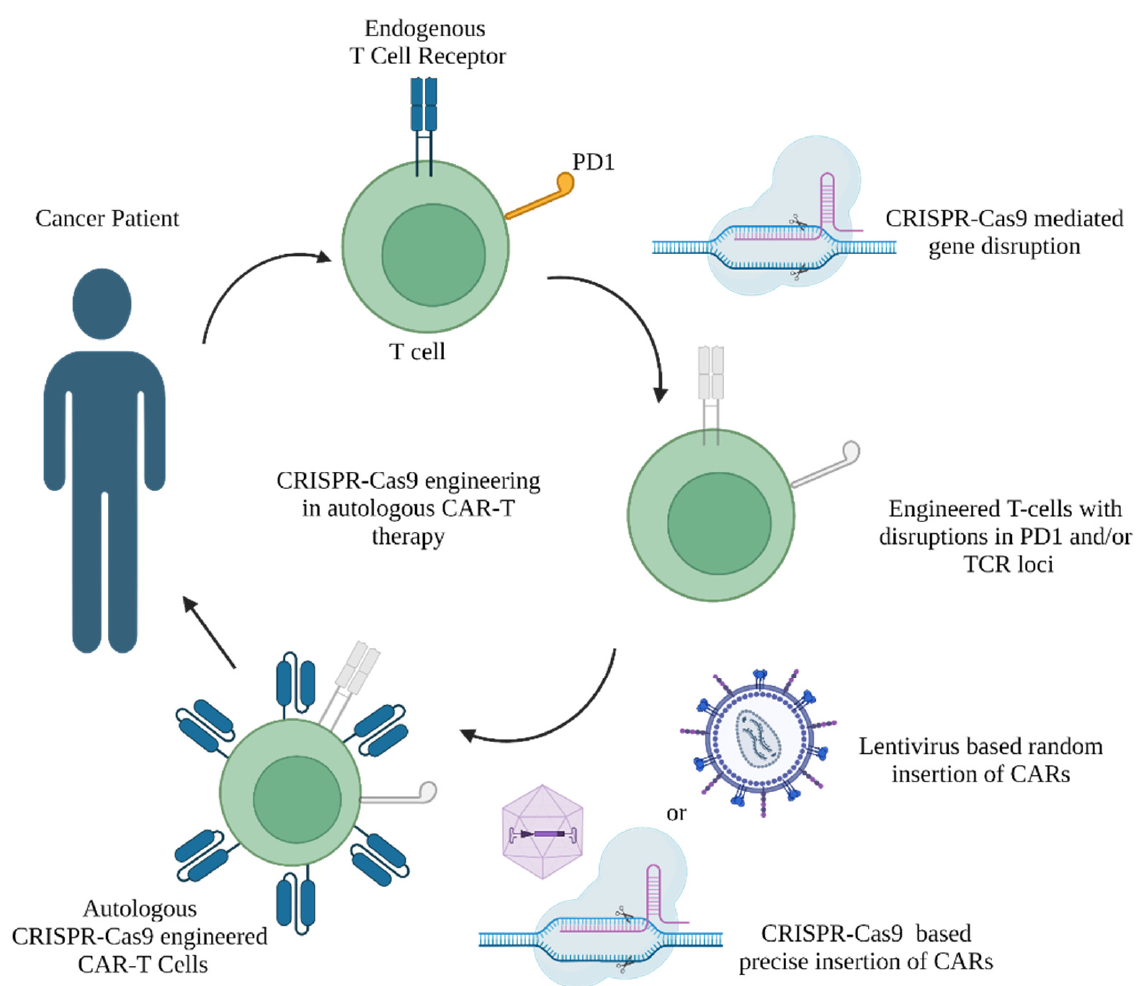
Figure 2. A scheme of CRISPR-Cas9 engineering in autologous CAR-T therapy. T cells are extracted from cancer patients and engineered with CRISPR-Cas9 to edit select genes. Later, chimeric antigen receptor (CAR) is randomly inserted into the genome via lentivirus or precisely engineered into a target locus via the CRISPR-Cas9 system to create an engineered autologous CAR-T cell. Engineered CAR-T cells are later given back to the cancer patients.